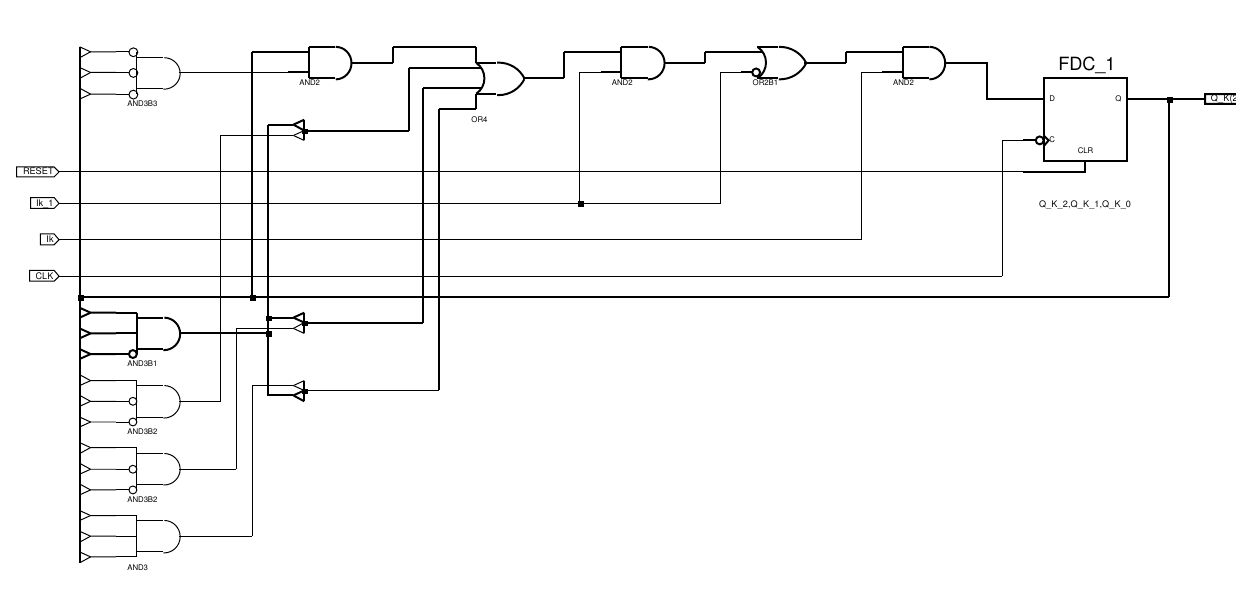
Figure 4. AC module automata for band 7 .